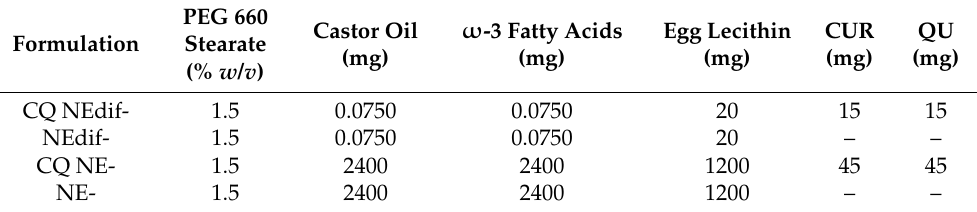
Table 1. Composition of the negative nanocarriers prepared through the HSD method (NEdif- and CQ NEdif-) and through HPH method (NE- and CQ NE-), both methods associated with the phase inversion temperature technique. Amount of CUR and QU in the formulation ( ± 1.75 mg/dL in total). PEG 660 Formulation Stearate